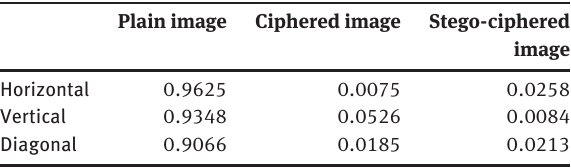
Table 5: Hand: Correlation analysis of two adjacent pixels.